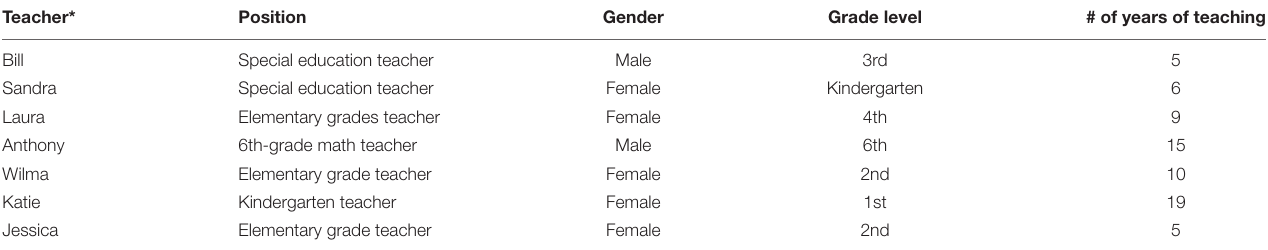
TABLE 1 | Demographic data on